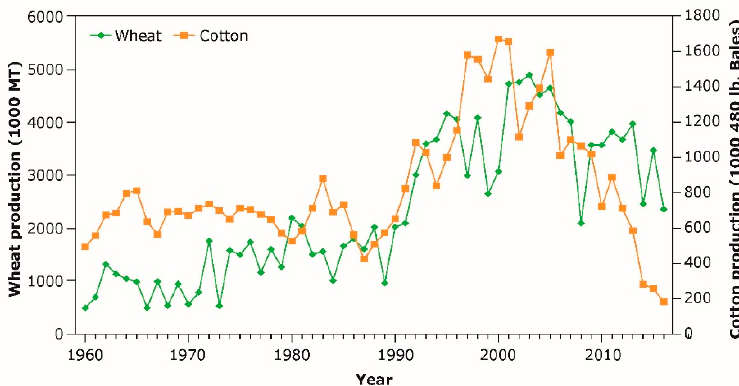
Figure 8. Temporal dynamics of wheat production, as representative of a winter-rainfed crop, and cotton production, as representative of a summer-irrigated crop. A severe production drop in the summer-irrigated crop is exhibited after 2010. Data extracted from http://www.indexmundi.com/.